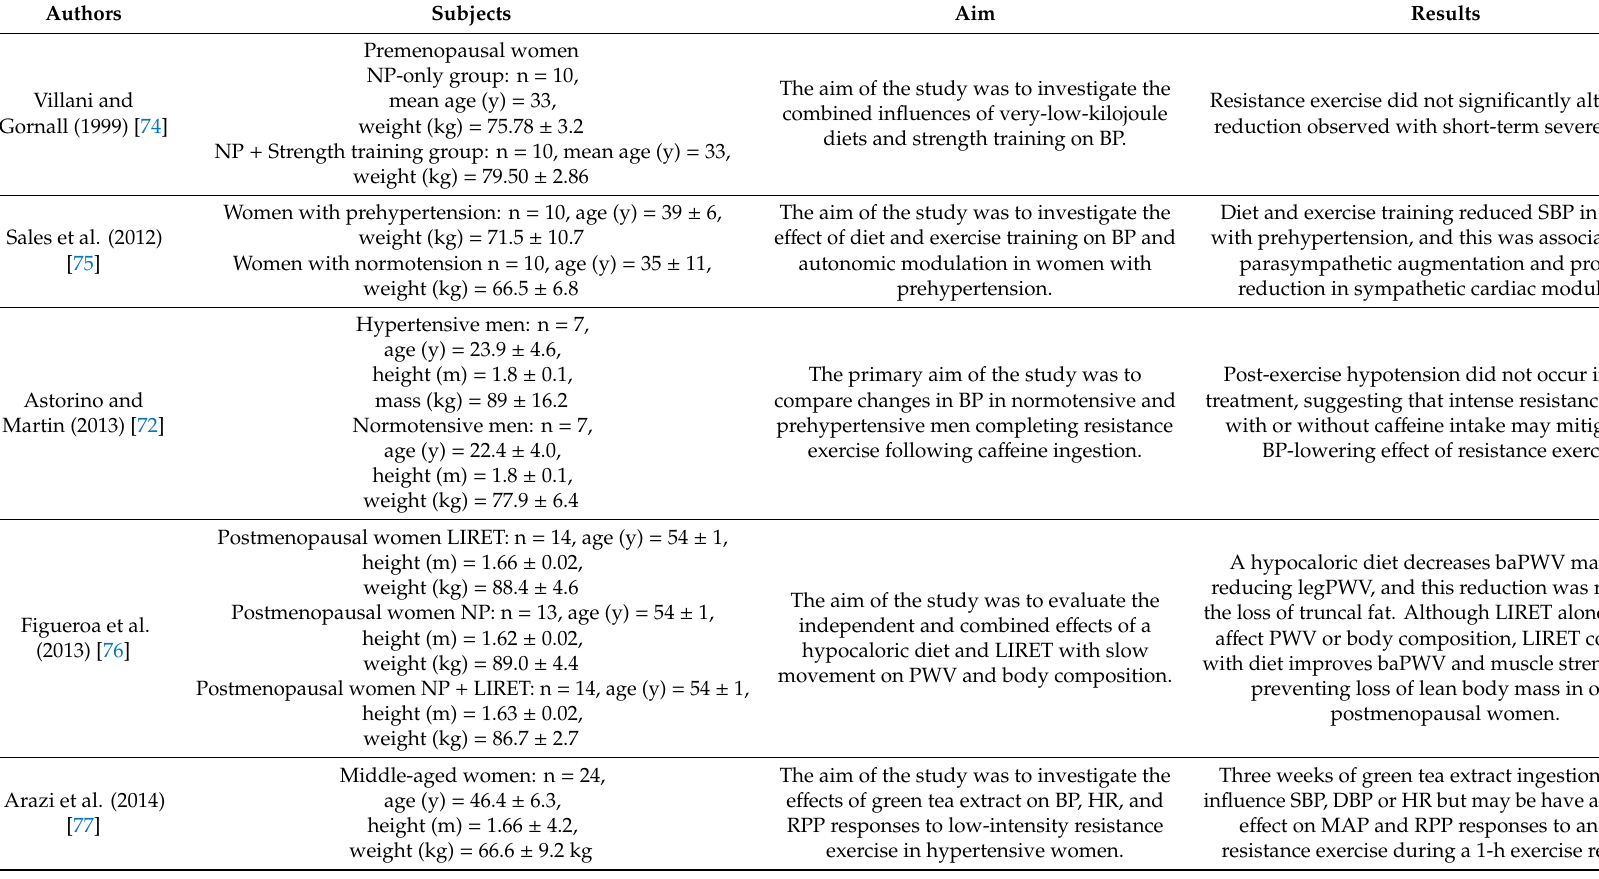
Table 1. General description of each study, sample, and intervention